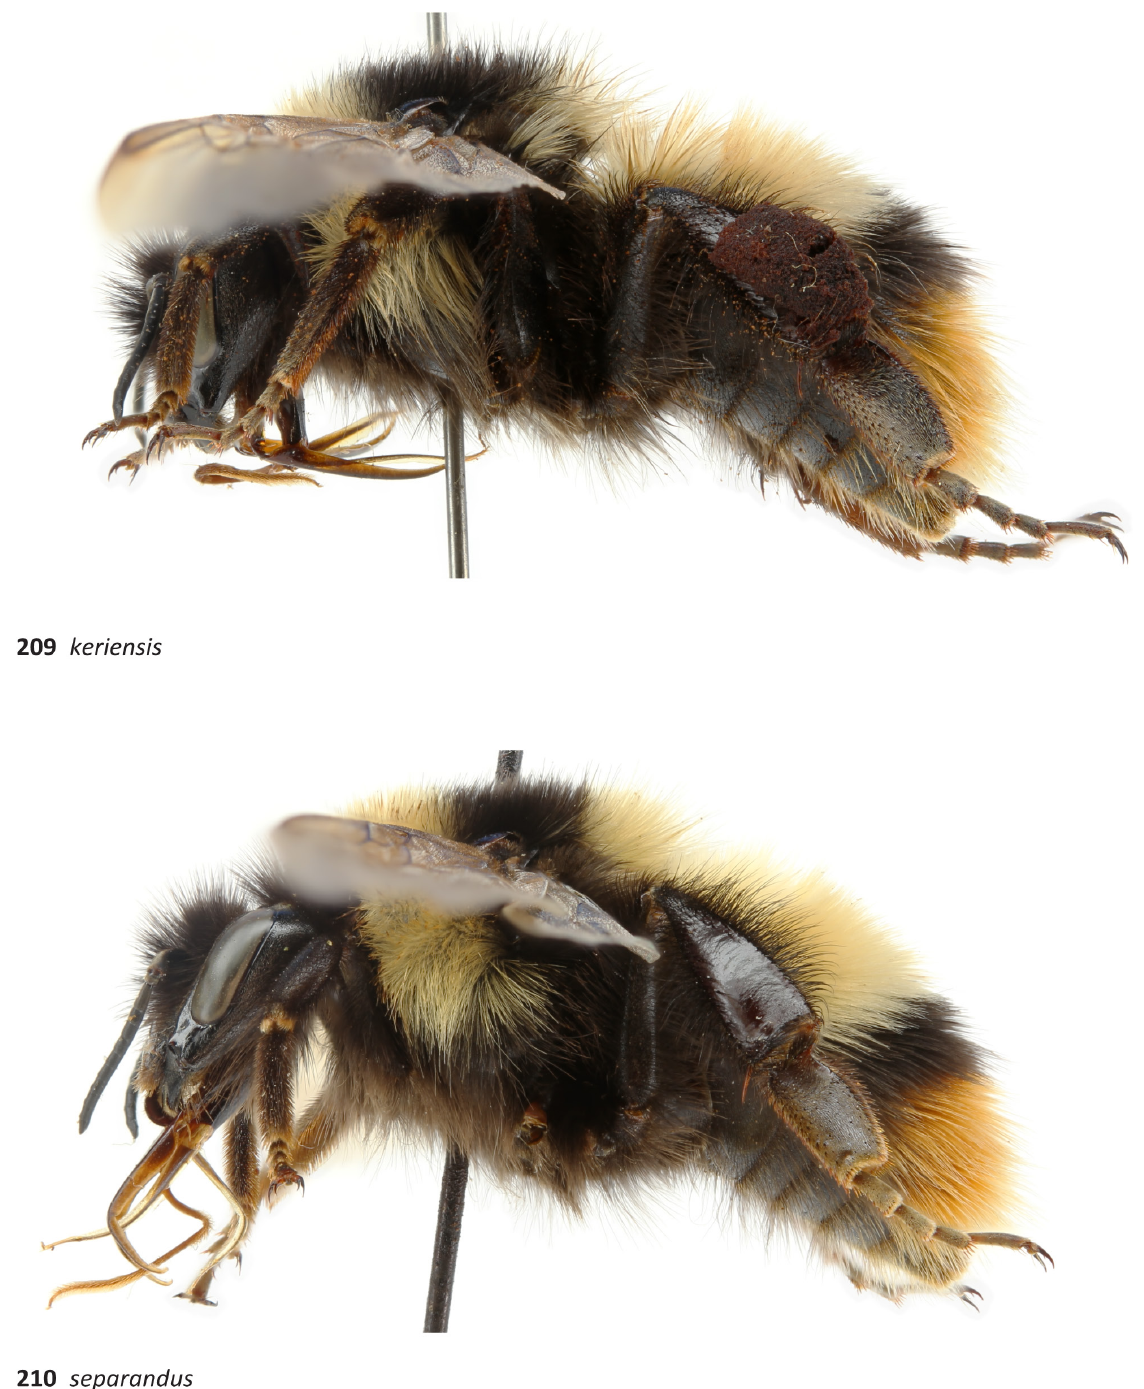
Figs 209–210. Images of queens of two cryptic species from around the western Qinghai-Tibetan plateau. 209 . Bombus keriensis Morawitz, 1887 from Mt Apharwat (4000 m a.s.l.) in the Pir Panjal mountains (ML405). 210 . B. separandus Vogt, 1909 stat. rev. from Nimaling plain (4800 m a.s.l.) in the Zanskar mountains (ML311). Viewed from the left lateral